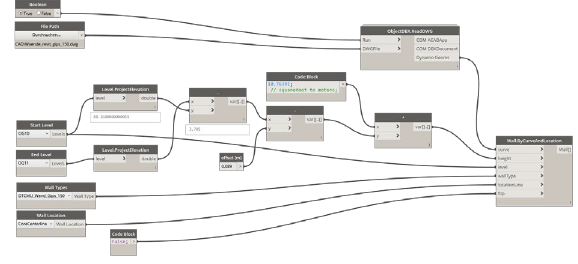
Figure 5. Algorithm developed by student (M. Ammann) to automatically place and adapt objects basing on 2D CAD plans and inputs from the user.